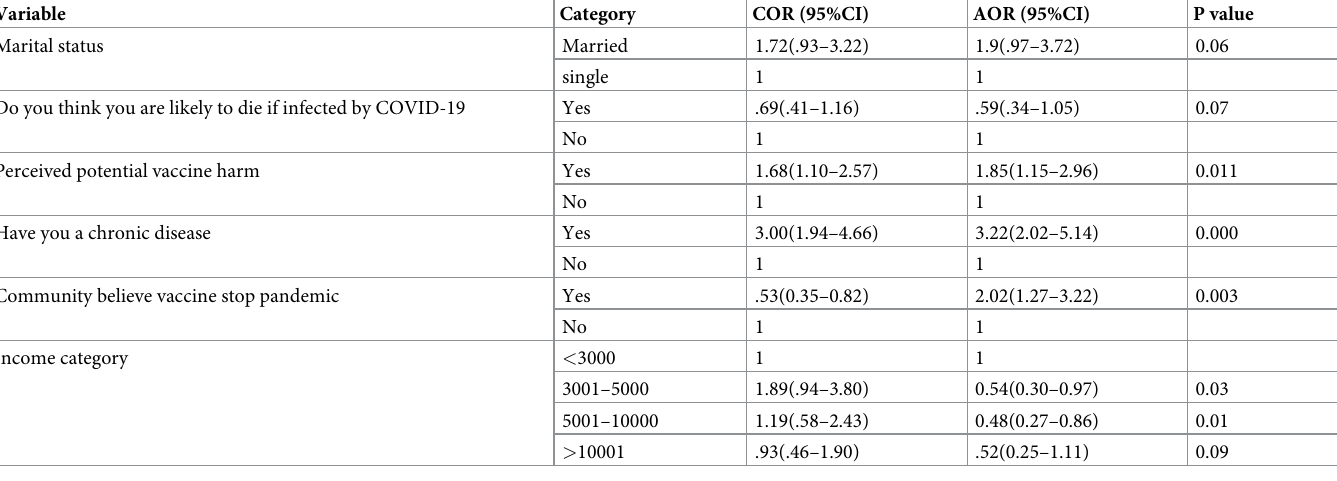
Table 3. Participants with factors associated with acceptance of COVID-19 vaccine in the Gurage zone, Southern Ethiopia, 2021. Variable